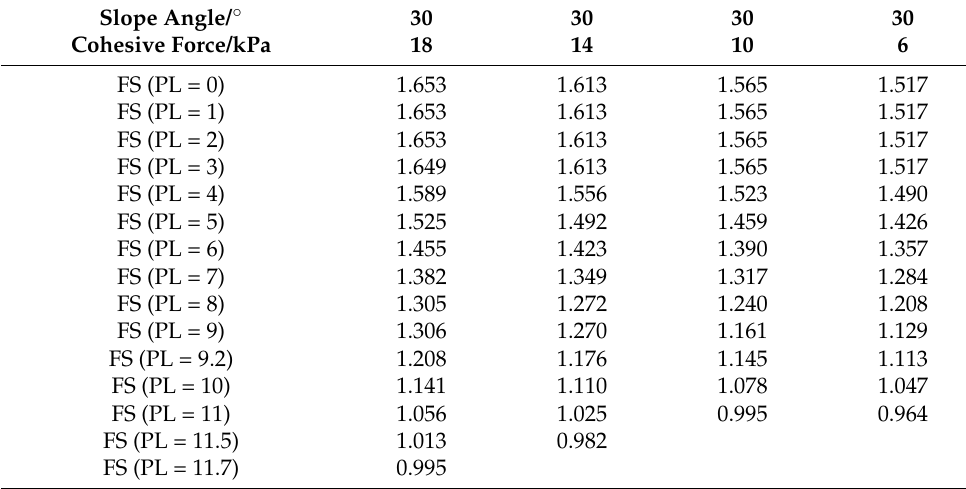
Table 5. FS for different cohesion/water line.